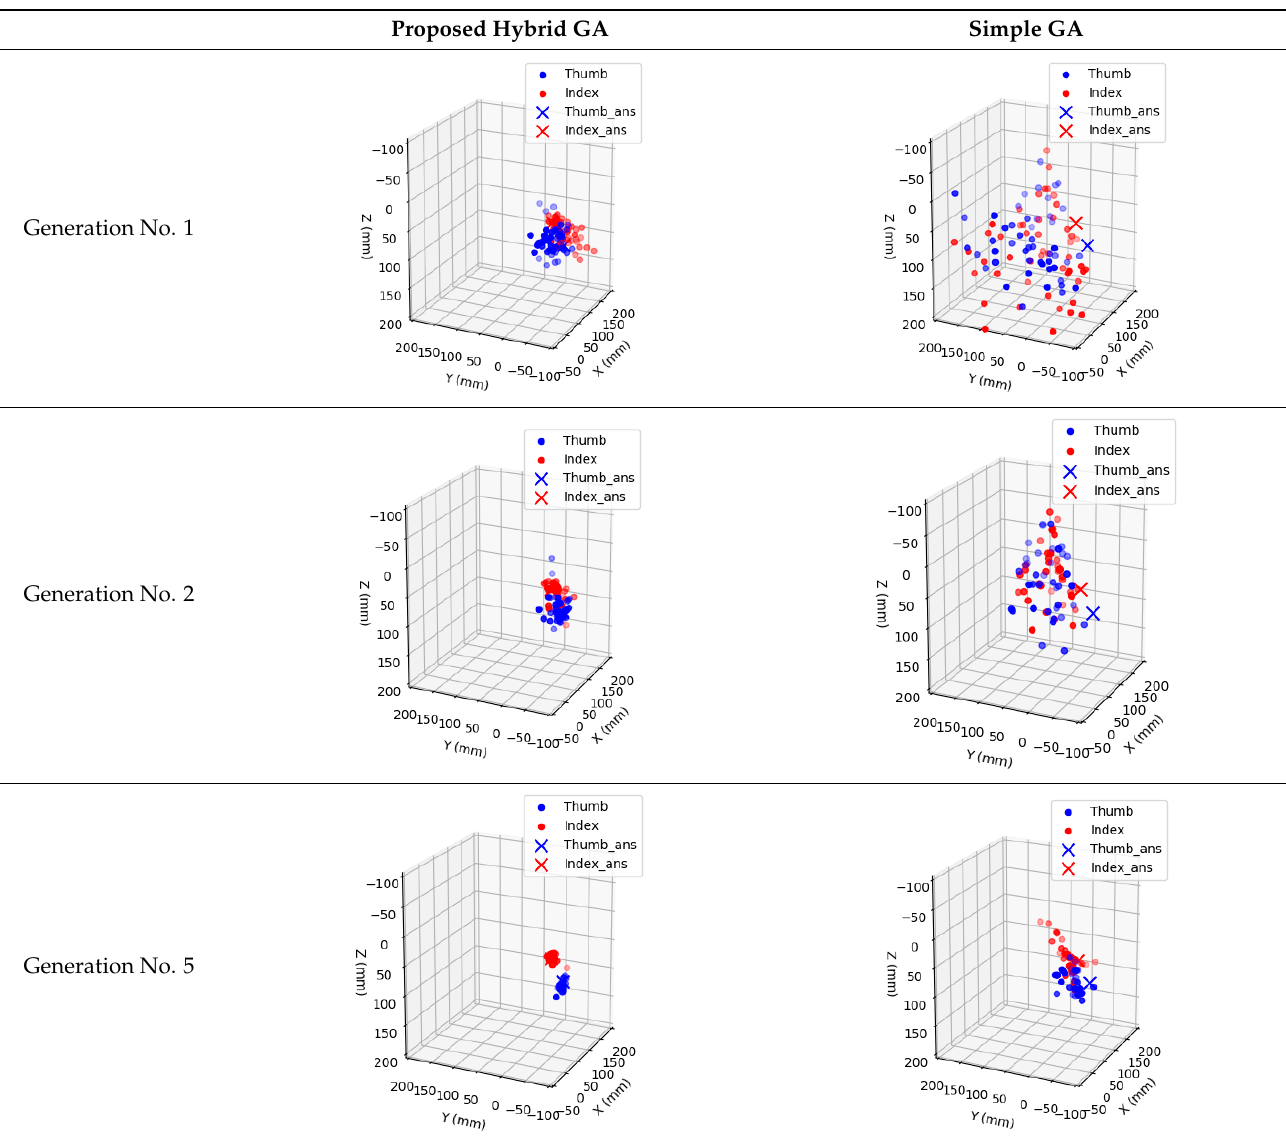
Table 6. Comparison of population distribution at different generations in the illustrated case #1.